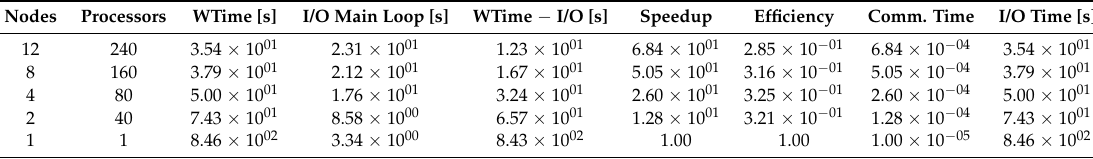
Table A5. Parallel performance of the low resolution stratified seamount experiment (1500 × 100 × 50) in the COD